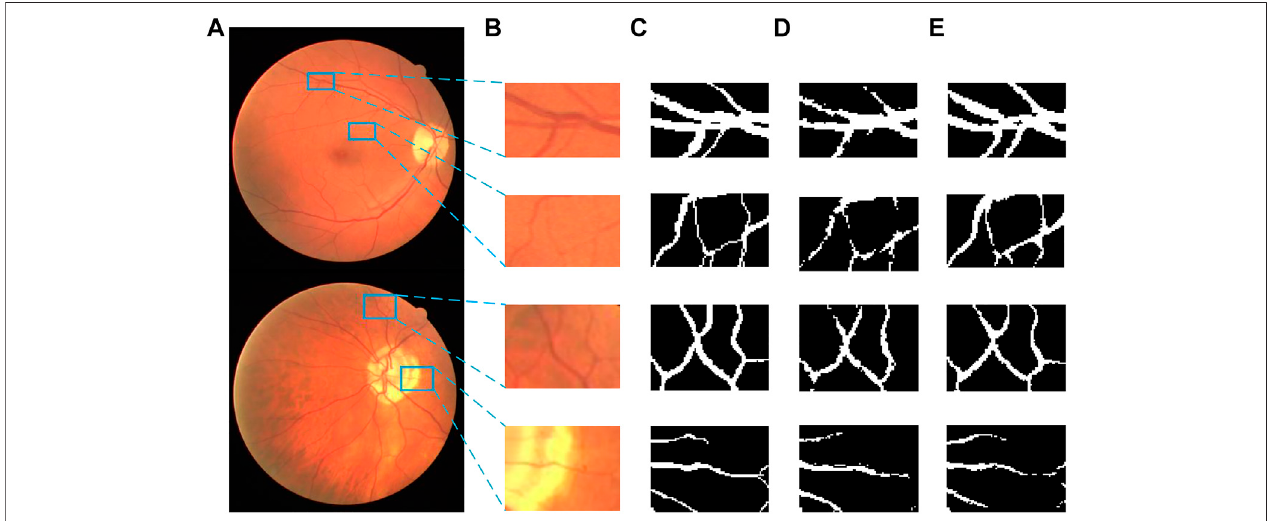
FIGURE 14 | Comparation of local segmentation effects on DRIVE data sets: (A) Original fundus image; (B) Original local image; (C) Local reference standard image; (D) Local segmentation results in Ref. (Fan et al., 2019); and (E) Local results by proposed method.